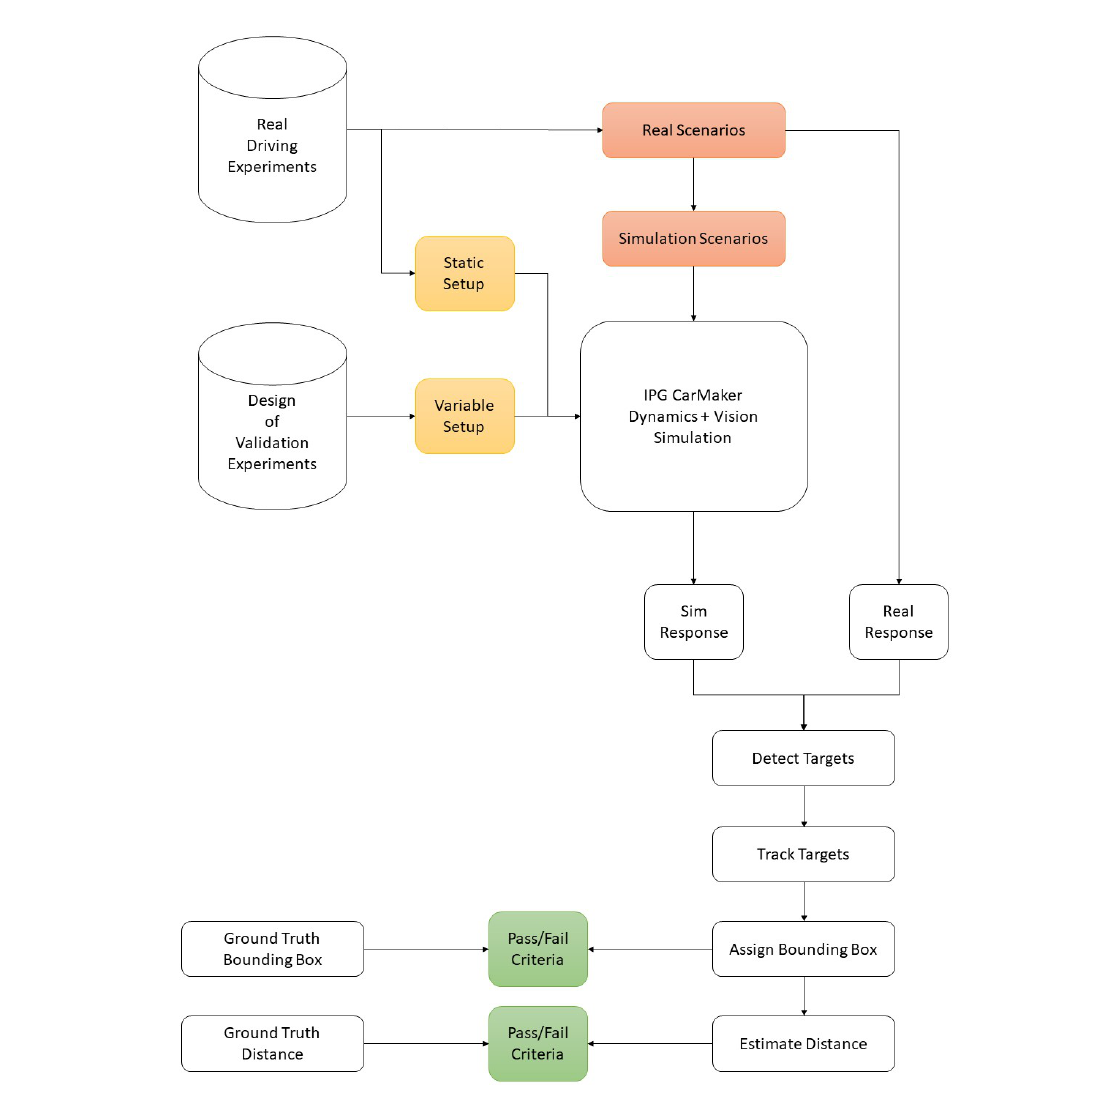
Figure 4. IPG CarMaker vehicle vision simulation model validation